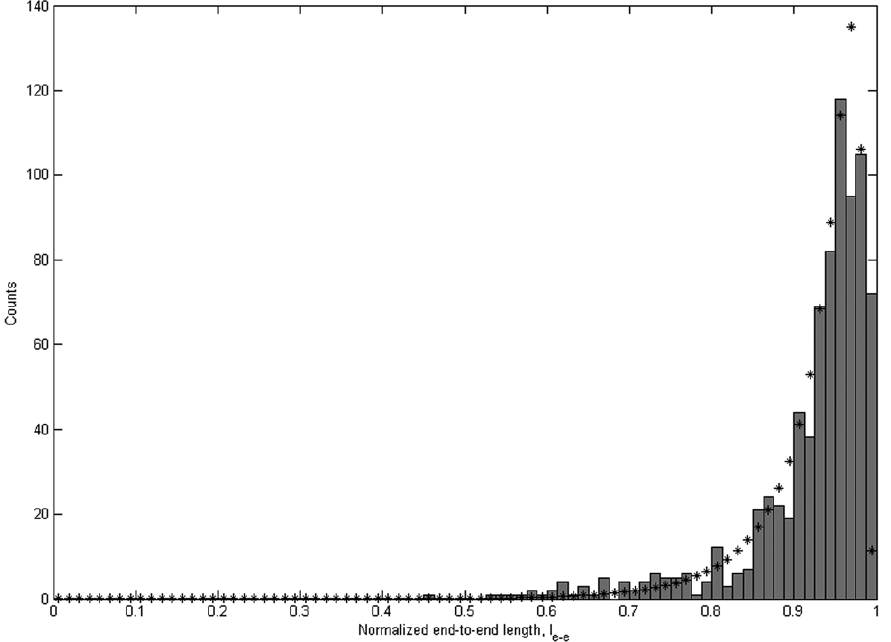
Figure 5. End-to-end length analysis shows L p of WT human cardiac a Tm consistent with tangent angle correlation analysis. Normalized end-to-end length (l e-e ) distributions from one of the WT a Tm samples incubated on p-Lys coated mica substrate for 600 s (N=798) fits to the WLC model (Eq. 3). l p value from the fit was 1.0425 6 0.0505 (R 2 =0.88). Errors were estimated by the jackknife method (Materials and Methods).